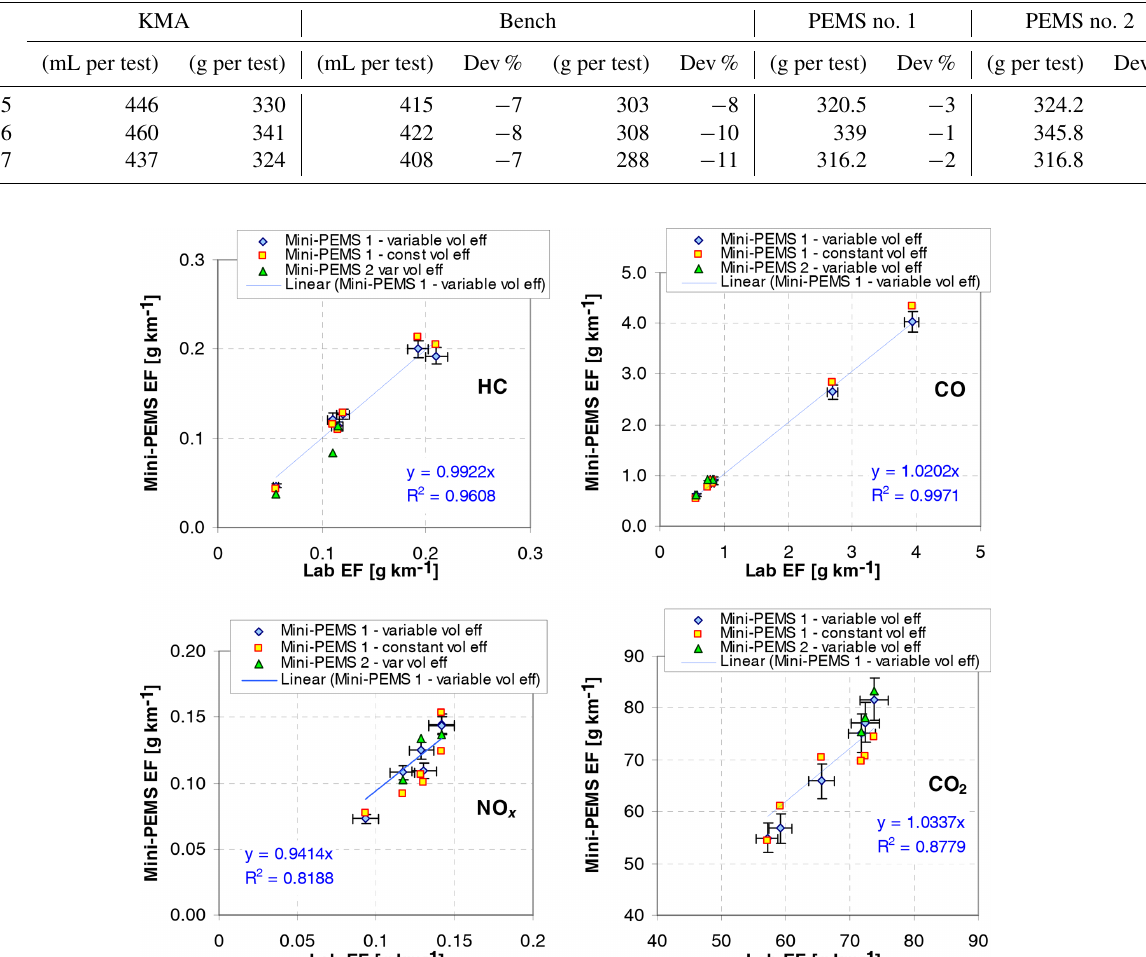
Figure 5. Emission factors of HC, NO x , CO, and CO 2 from bench instrumentation (horizontal axis) and Mini-PEMS No. 1 (vertical axis) obtained during roller bench tests. For Mini-PEMS No. 1, variable volumetric efficiency, error bars represent estimated known measurement uncertainty of 5% for Mini-PEMS and for laboratory, 3% for CO and CO 2 , 5% (10% for 50mgkm − 1 ) for HC, and 7.5mgkm − 1 for NO x